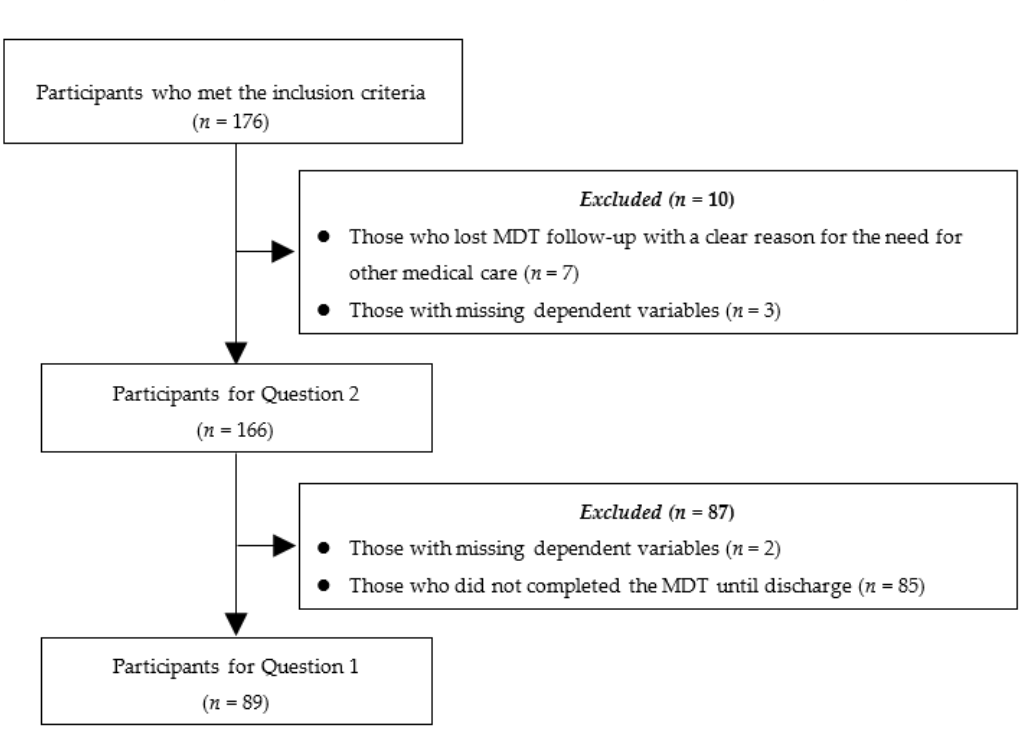
Figure 1. Flow of inclusion / exclusion of the participants. Abbreviations: MDT—mechanical diagnosis and therapy.